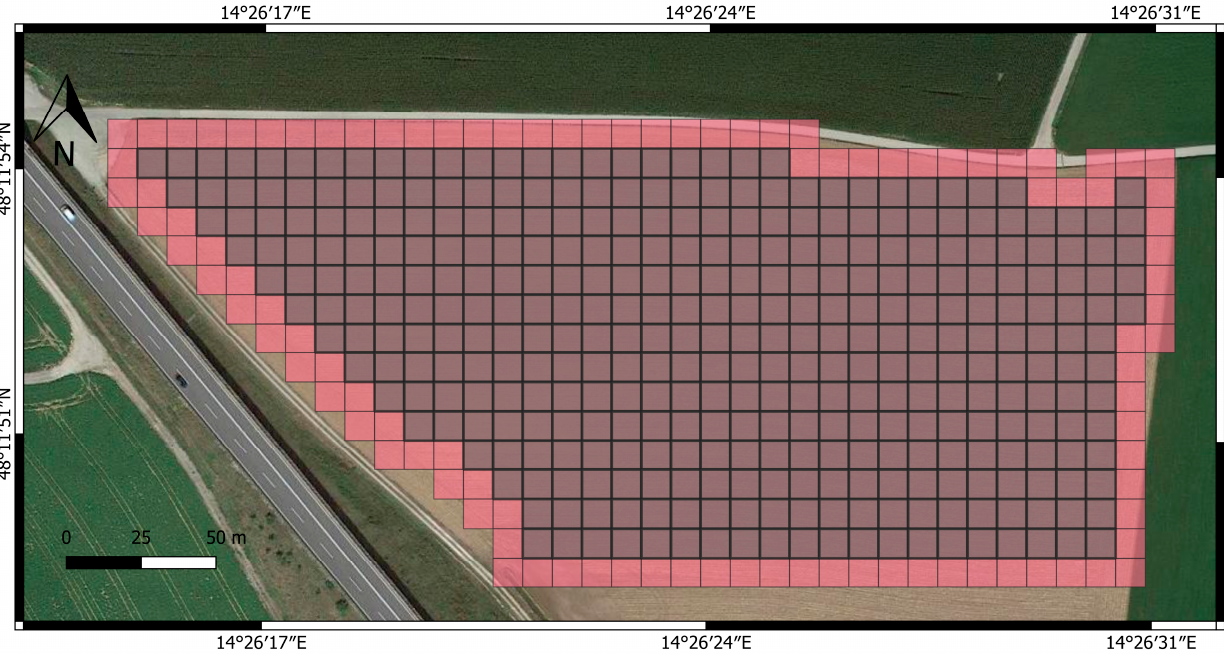
Figure 7. Graphic representation of Sentinel-2 pixel grid. Border pixels excluded from the analysis are noted in red while the pixels for further processing are marked in